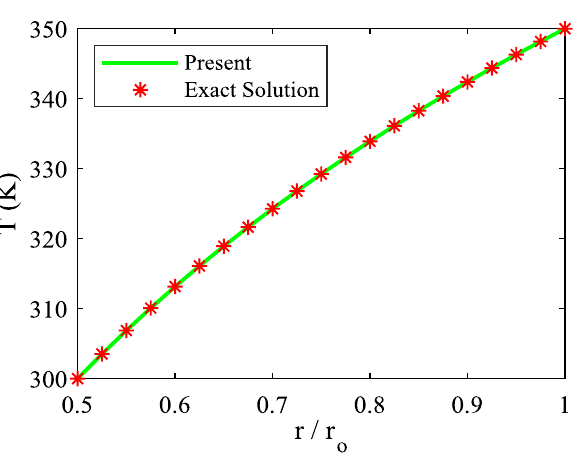
Figure 4: Comparison between temperature profiles along cylinder thickness obtained from the present method and exact solution [42]